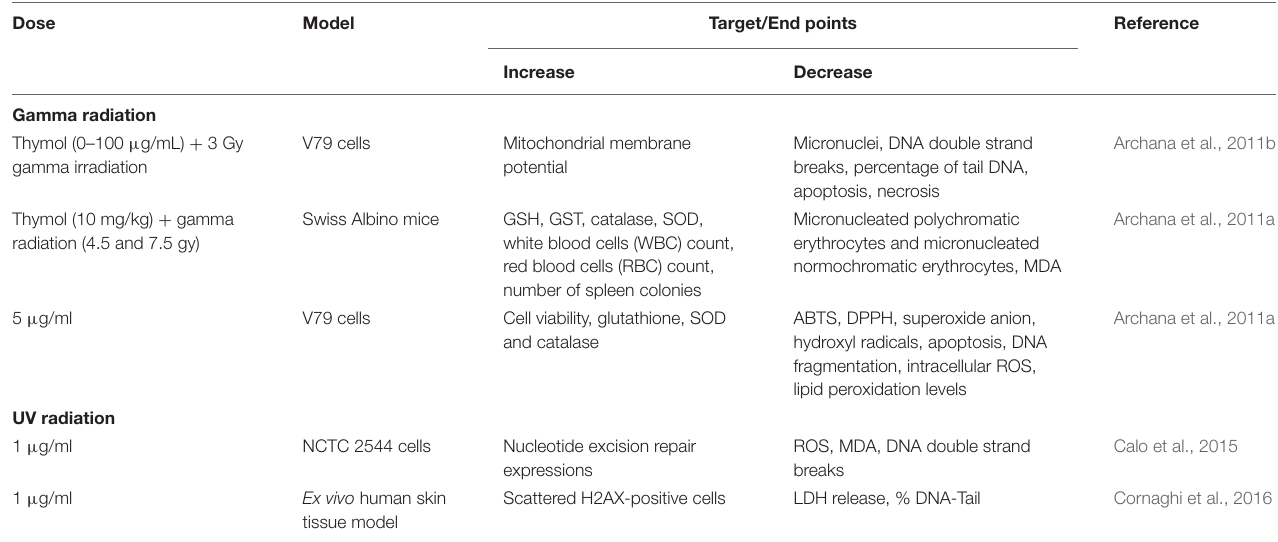
TABLE 7 | Effect of thymol on radiation